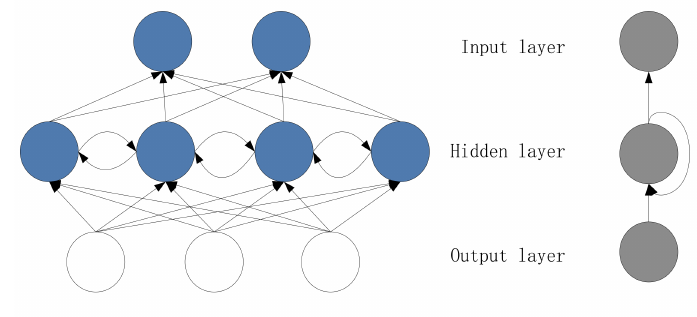
Figure 1. A recurrent neural network (RNN) structure